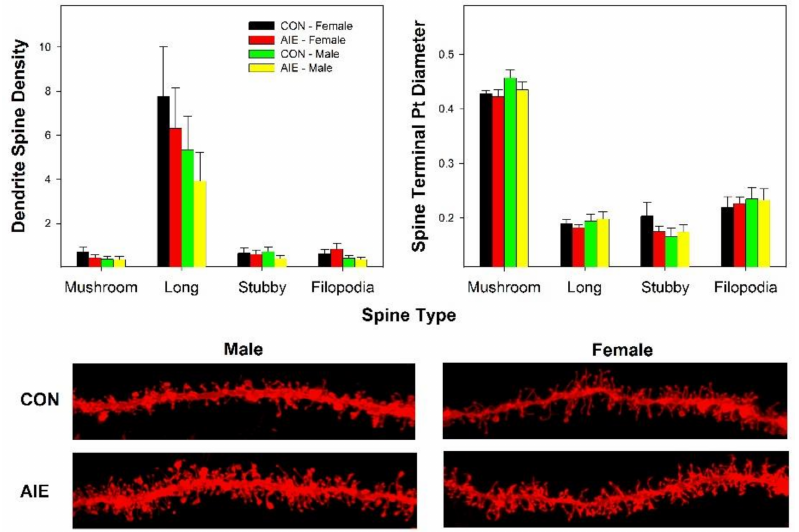
Figure 4. Dendritic Spine Density (left panel) and Spine Terminal Point (Pt) Diameter in the AcbSh in CON and AIE exposed rats during adulthood. Representative images of distal dendritic segments of medium spiny neurons in the AcbSh. There were no significant findings. Data are mean ±